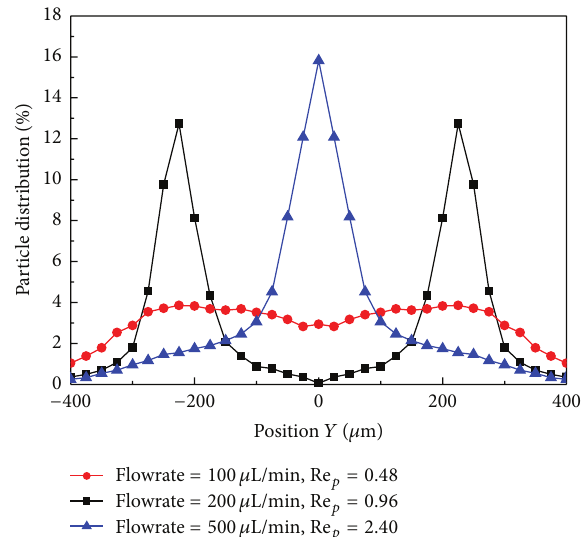
Figure 8. The particle distribution for particle sizes 7